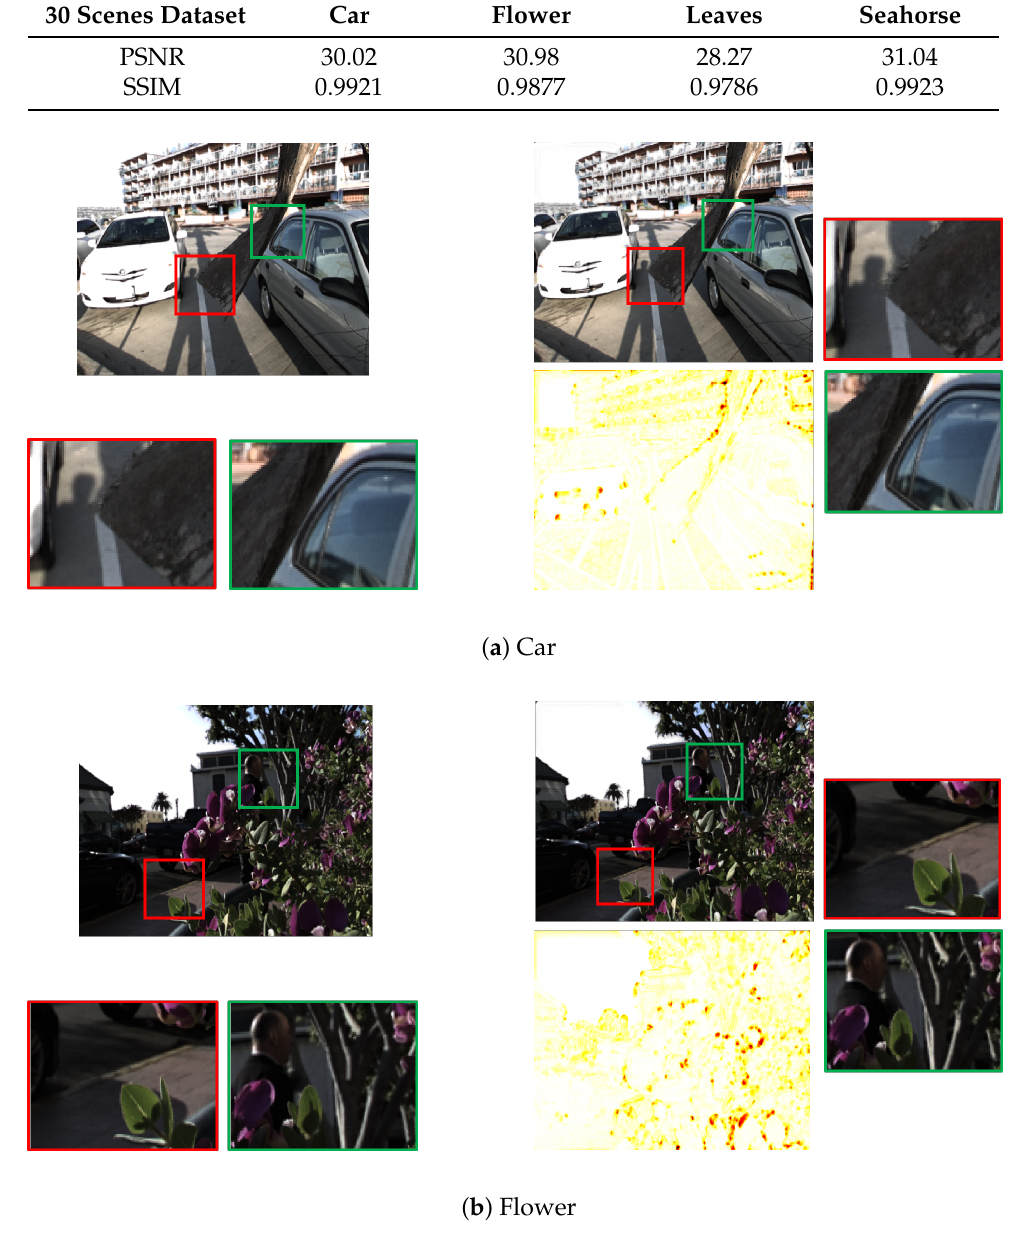
Table 8. PSNR and SSIM for the four images shown in Figure 13 from the 30-scenes dataset.